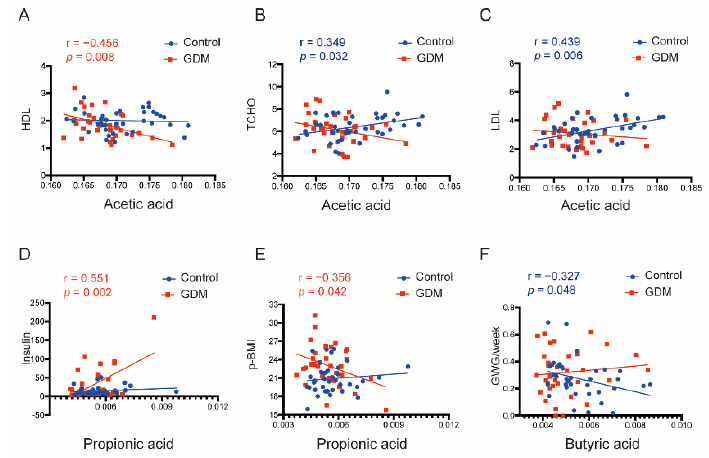
Figure 3. Correlation analysis between acetic, propionic, and butyric acid contents and clinical indi- cators in T2. ( A – D ) Associations between acetic acid and WBC, NEU counts, TCHO, or HDL levels in either group. ( E , F ) Associations between propionic acid and insulin levels. ( G ) Comparisons of GDM diagnostic models including acetic, propionic, butyric acid, and other parameters. WBC, white blood cell; NEU, neutrophil; TCHO, total cholesterol; HDL, high-density lipoprotein.